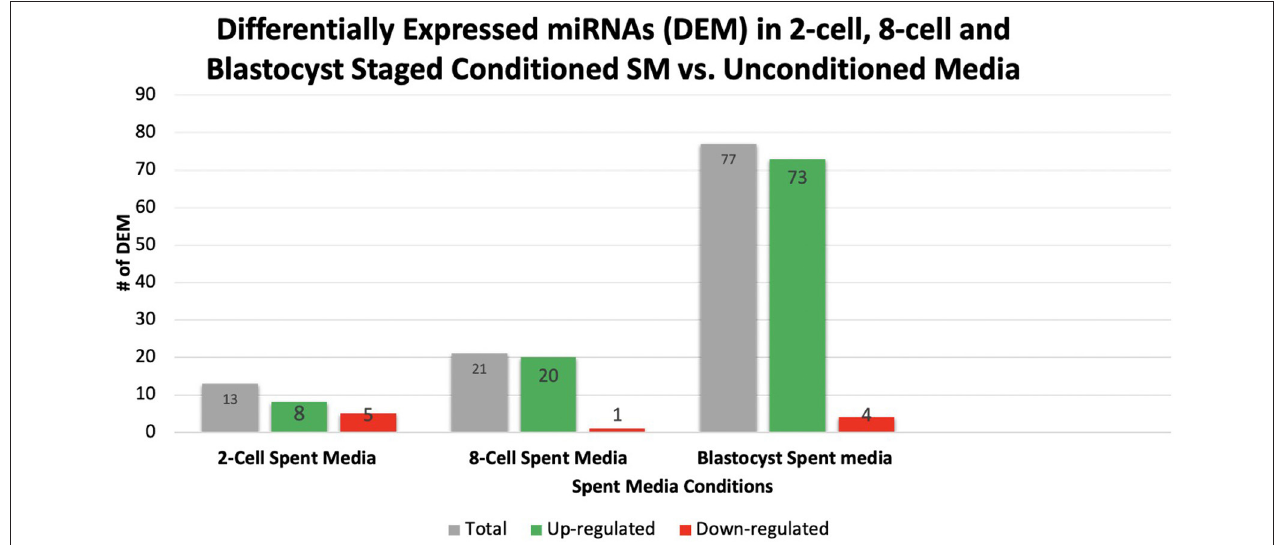
FIGURE 1 | A total of 111 miRNAs were differentially expressed in 2-cell, 8-cell, and blastocyst spent media. Expression of miRNAs in spent media increased throughout the 3 conditions examined, with 13, 21, and 77 miRNAs being detected in 2-cell, 8-cell, and blastocyst spent media, respectively. The majority of miRNAs detected in spent media were blastocyst derived.